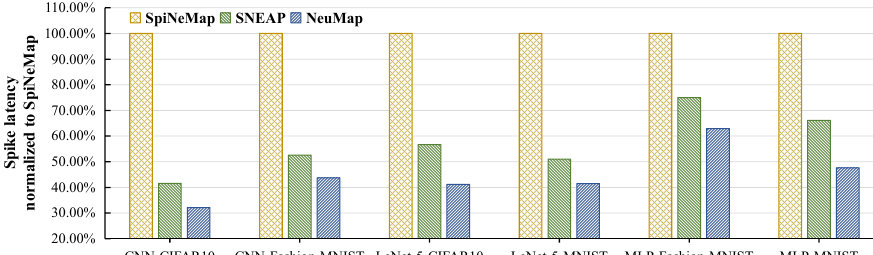
Figure 14. The spike latency normalized to